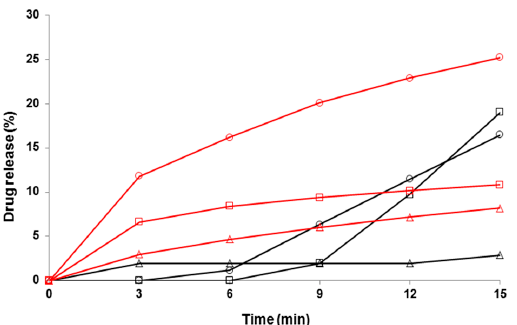
Figure 8. Early-phase dissolution of piroxicam (PRX)-loaded hydroxypropyl methylcellulose (HPMC) nanofibers freely set into the dissolution baskets ( n = 6). The ratio of a carrier polymer (HPMC) and